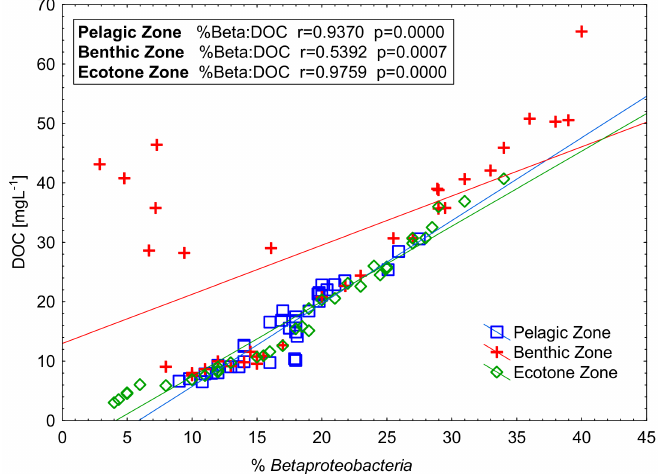
Figure 8. The relationship between participation in bacterial community Betaproteobacteria and the content of dissolved organic carbon (DOC) in the zones of examined peat-bog